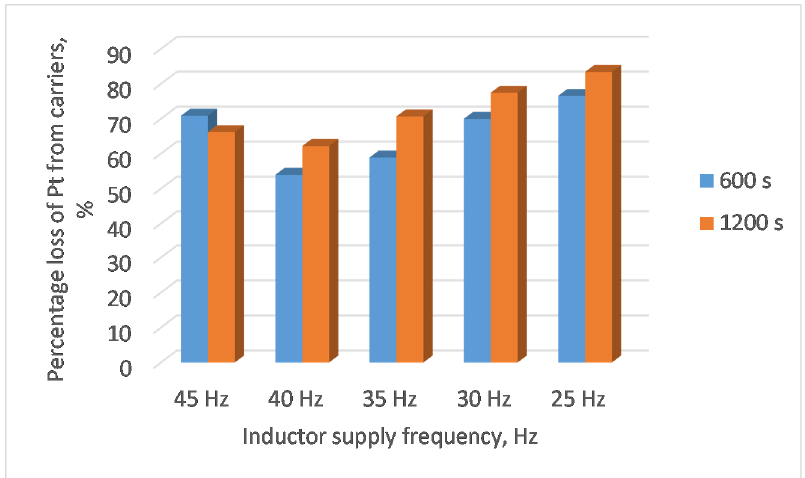
Figure 8. Results of percentage platinum washed from carriers with different inductor supply frequencies for two different device operating times, 600 and 1200 s.